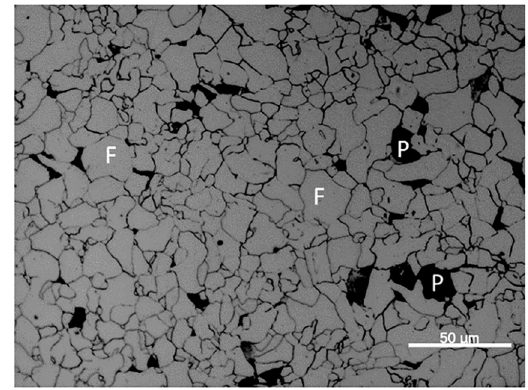
Figure 3. Microstructure of API X52 steel obtained by optical